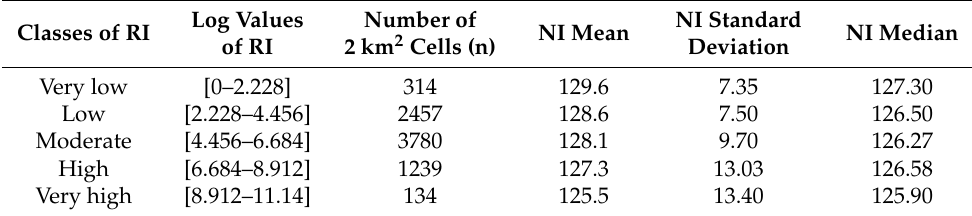
Table 3. Descriptive statistics of records in each RI class.